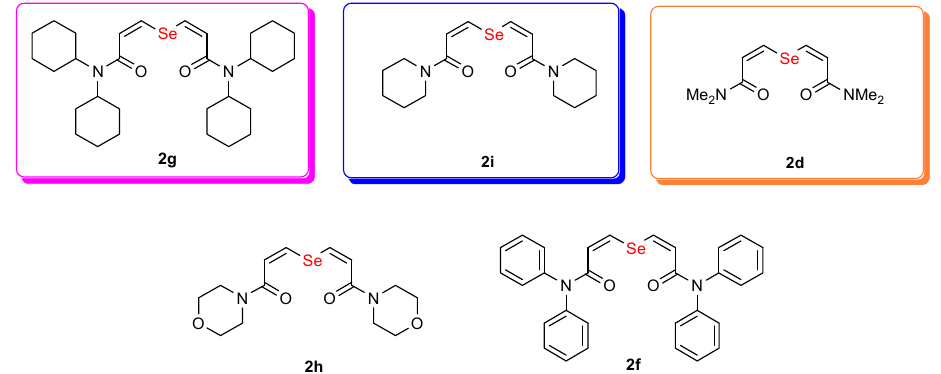
Figure 5. Compounds 2d , f , g , h , i exhibiting higher glutathione peroxidase-like activity compared to Ph 2 Se 2 (the compounds are arranged in the decreasing order of the